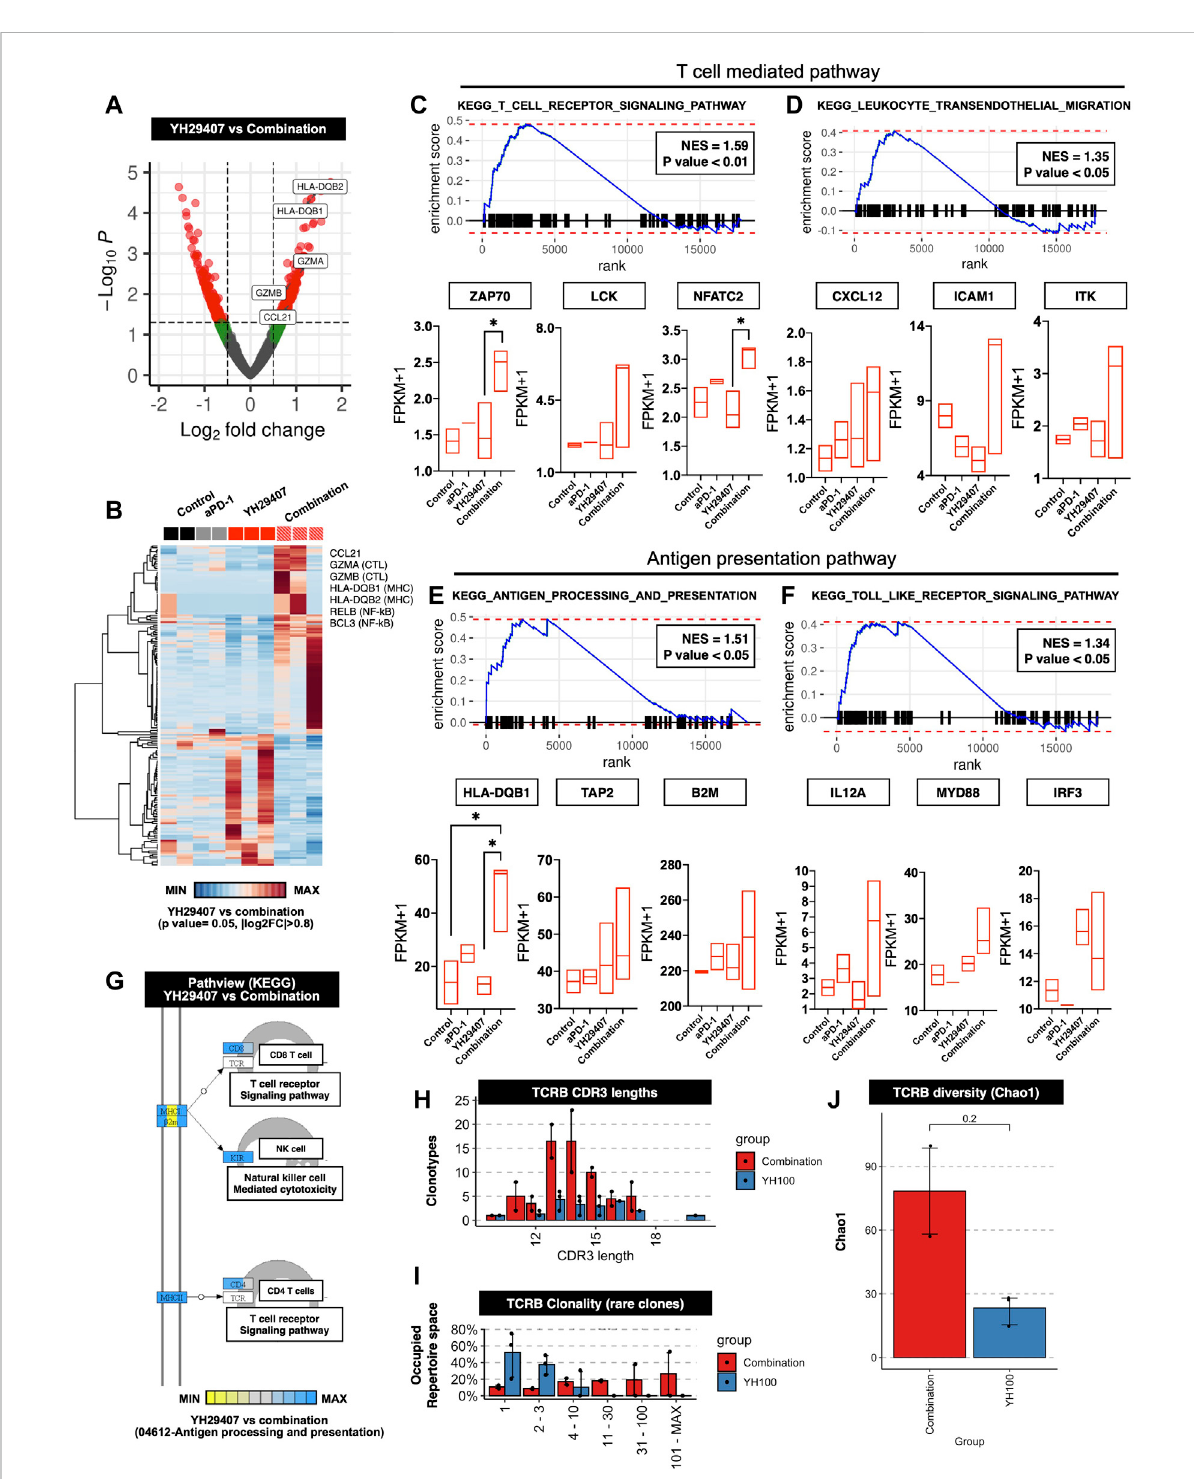
Differentially expressed genes (DEGs) and gene set enrichment analysis (GSEA) between the progression of YH29407+aPD-1 and other treatment groups. (A) Volcano plots of 17,871 genesused to compare DEGsinYH29407+aPD-1 and YH29407treatment.DESeq2 package was used forfoldsofgeneexpressionandstatisticalanalysis(folds S |2|, p < 0.05).Individualgeneexpressionandpvaluesaredisplayedascoloreddots(gray= non-signi fi cant and non-fold changes, green = folds > |2|, red = folds S |2|, and p < 0.05). Compared to YH29407 alone, lower expression of 138genesandhigher expressionof221geneswereidenti fi edintheYH29407+aPD-1group. (B) Heatmapsshowthecoreenrichmentgenesofeach